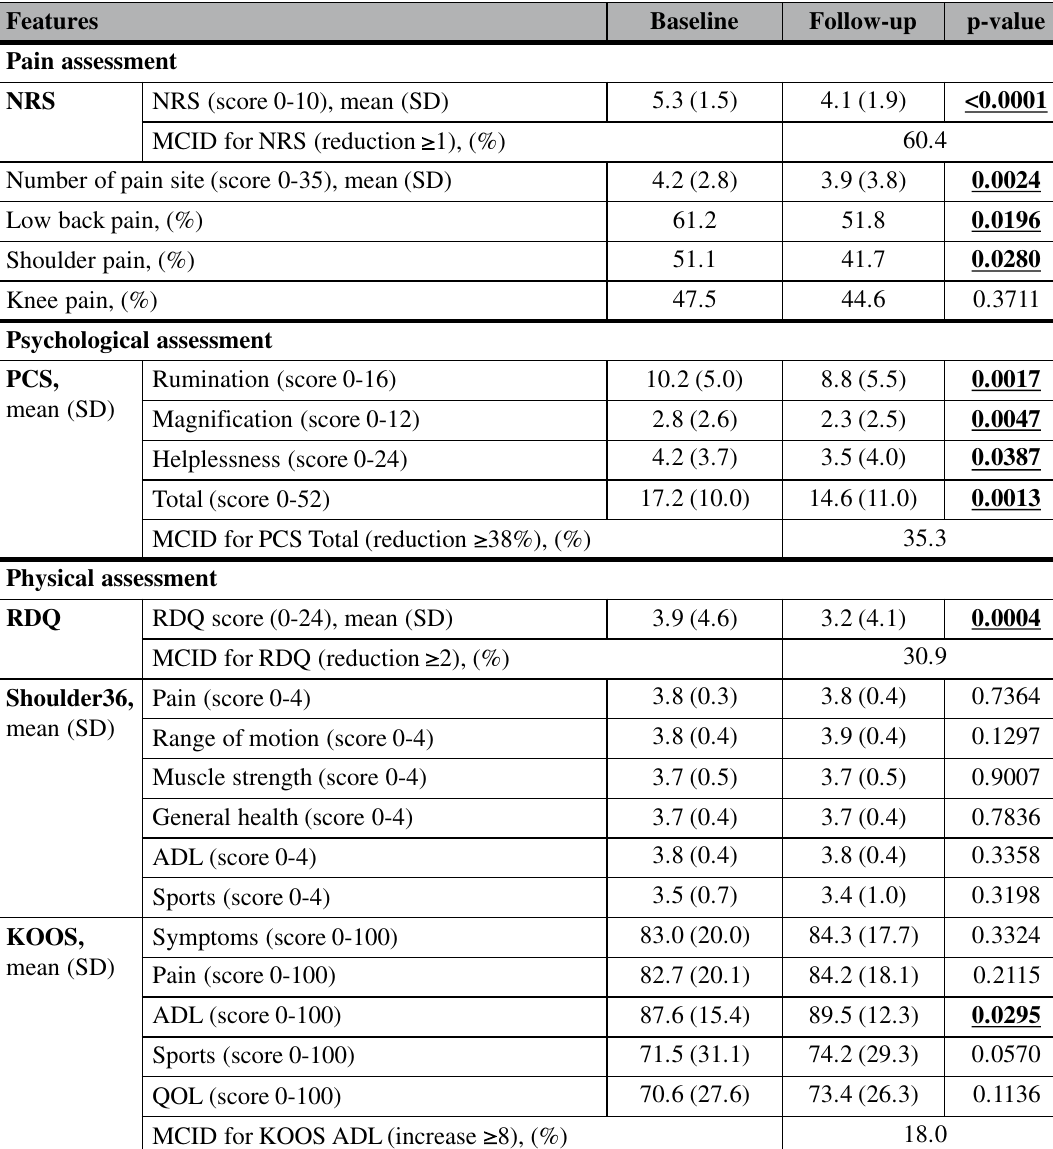
Table 2. Comparison of pain and associated functions between baseline and 3 months after intervention. NRS score, number of pain site, and the prevalence of pain in the low back and shoulder were significantly reduced after the intervention relative to baseline. In the psychological assessment, all PCS subdomain scores and the total score, were significantly improved after the intervention relative to baseline. For physical disability assessment, RDQ and the KOOS domain score for ADL were significantly increased, but Shoulder36 score did not significantly change, after the intervention relative to baseline. Group comparisons for continuous data were performed by Wilcoxon signed-rank test, and McNemar test was used for categorical variables. NRS: numeric rating scale; PCS: pain catastrophizing scale; RDQ: Roland-Morris disability questionnaire; KOOS: knee injury and osteoarthritis outcomes survey; MCID: minimal clinically important difference; SD: standard deviation; ADL: activities of daily living. Significant differences are indicated in